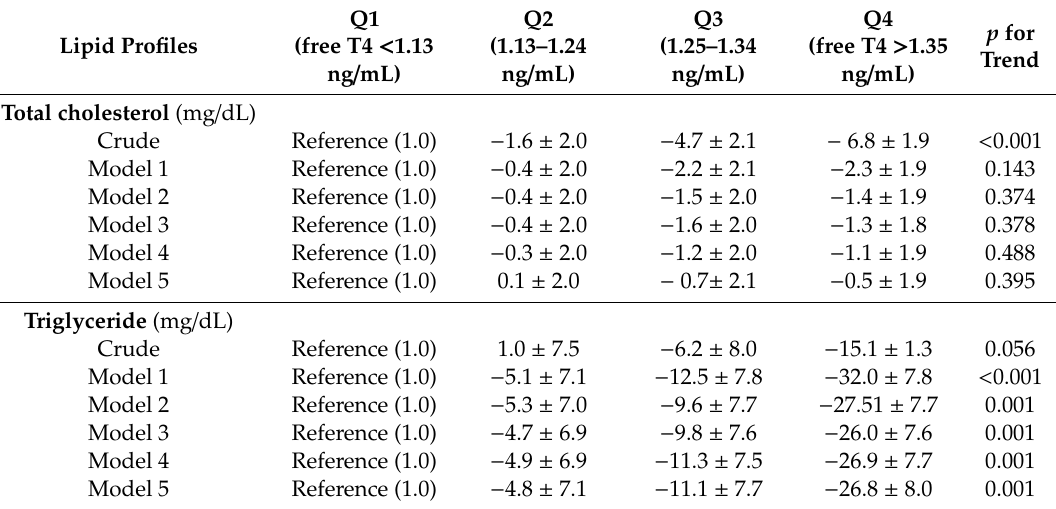
Table 2. Changes in lipid profiles according to free T4